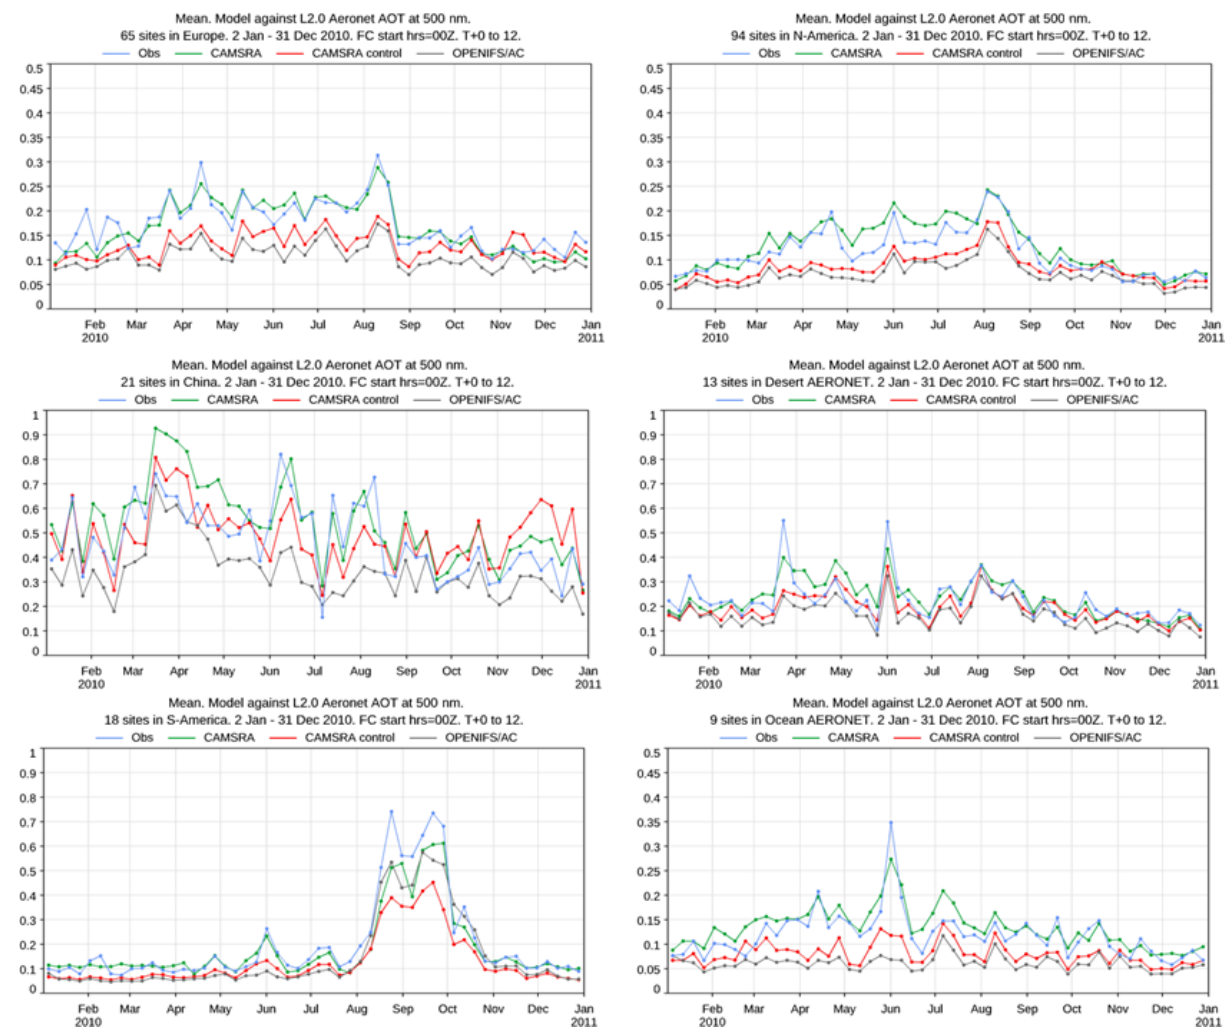
Figure 9. Evaluation of total AOD at 550nm from OpenIFS/AC against observations from AERONET at 500nm. Results from the CAMS reanalysis and its control experiment are also included for